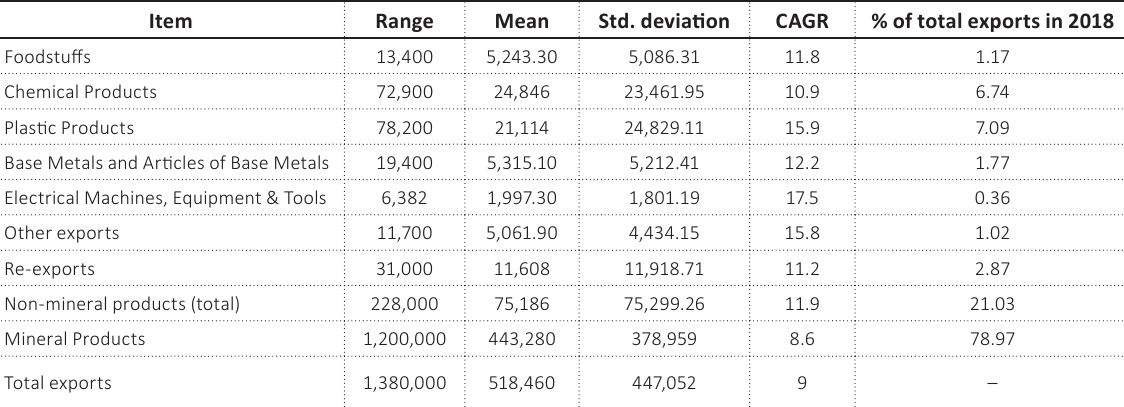
Table 10. Descriptive statistics of the